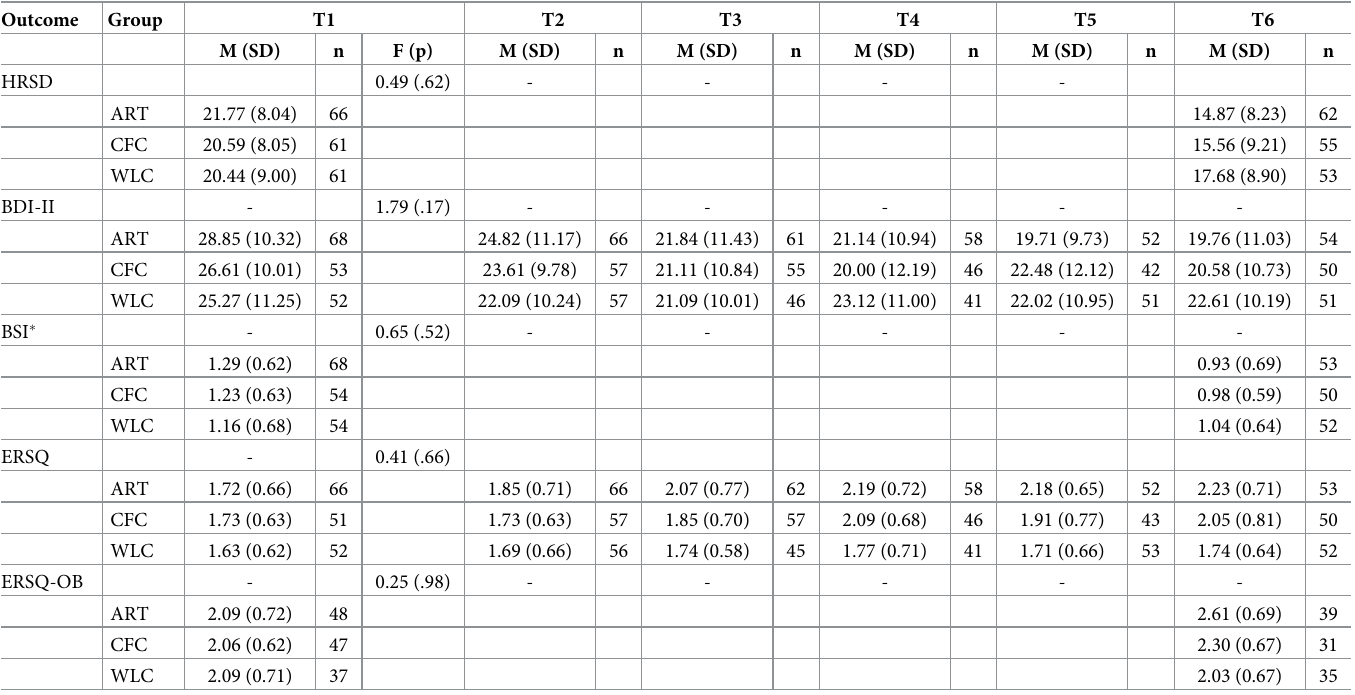
Table 2. Descriptive statistics for all measures by group at all assessment